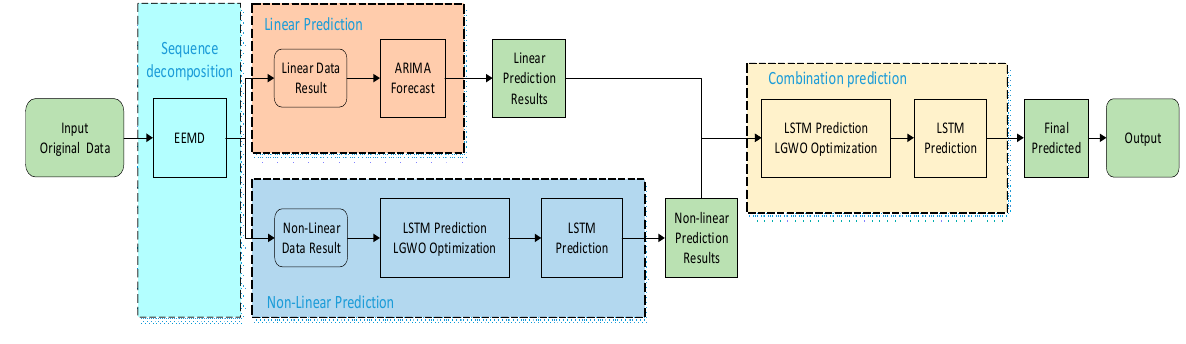
Figure 2. Overall framework diagram of IEALL.